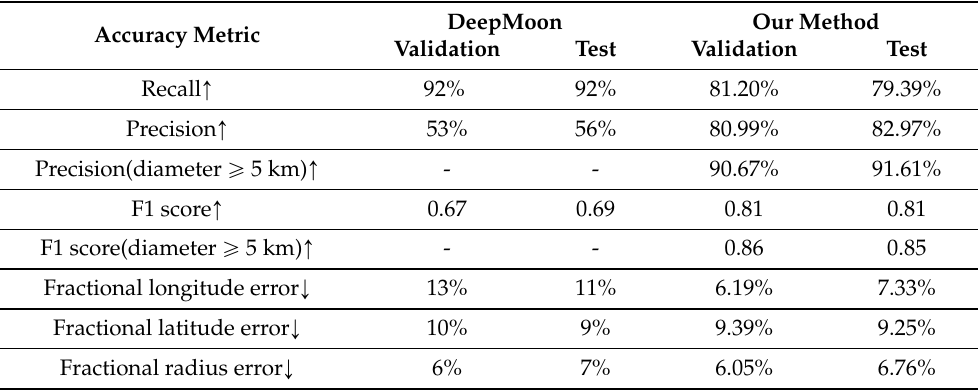
Table 3. Detection metrics of the DeepMoon method and our workflow using Faster R-CNN + FPN on the validation and test